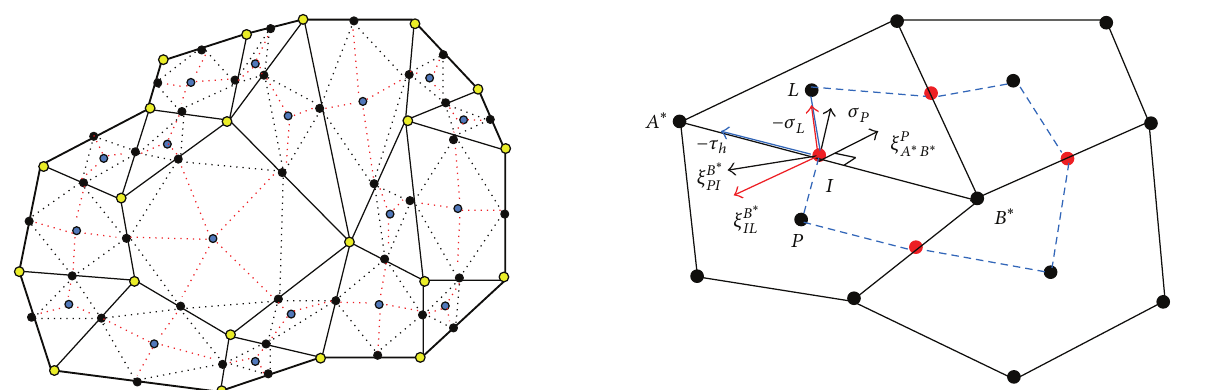
Figure4:Aprimarymeshinfulllineswiththeassociateddualmesh in red discontinuous lines and the corresponding auxiliary mesh in black dotted lines.